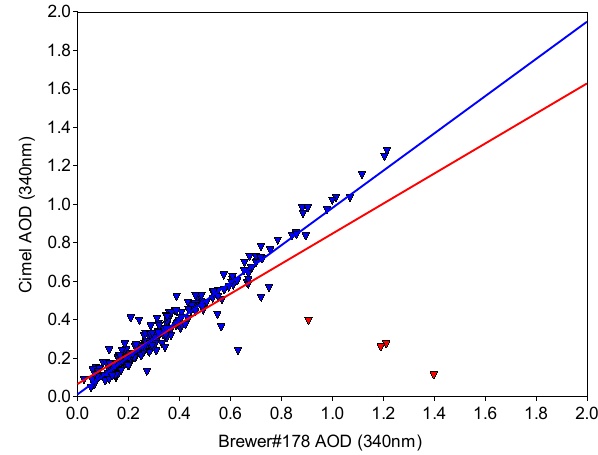
Fig. 2. Scatter plot of the Brewer and Cimel AOD at 340nm (time period for the comparison is 30min). The red curve represents f (x) = x .